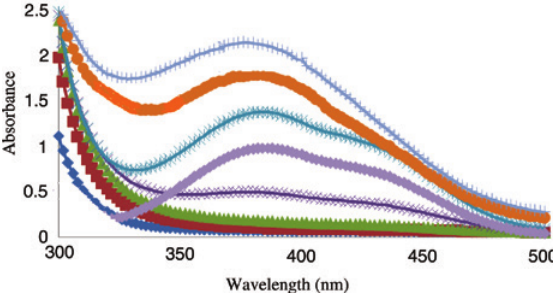
Figure 3: Absorption spectrum of the proposed method using met- ronidazole (MTL), at different nitrite concentrations.